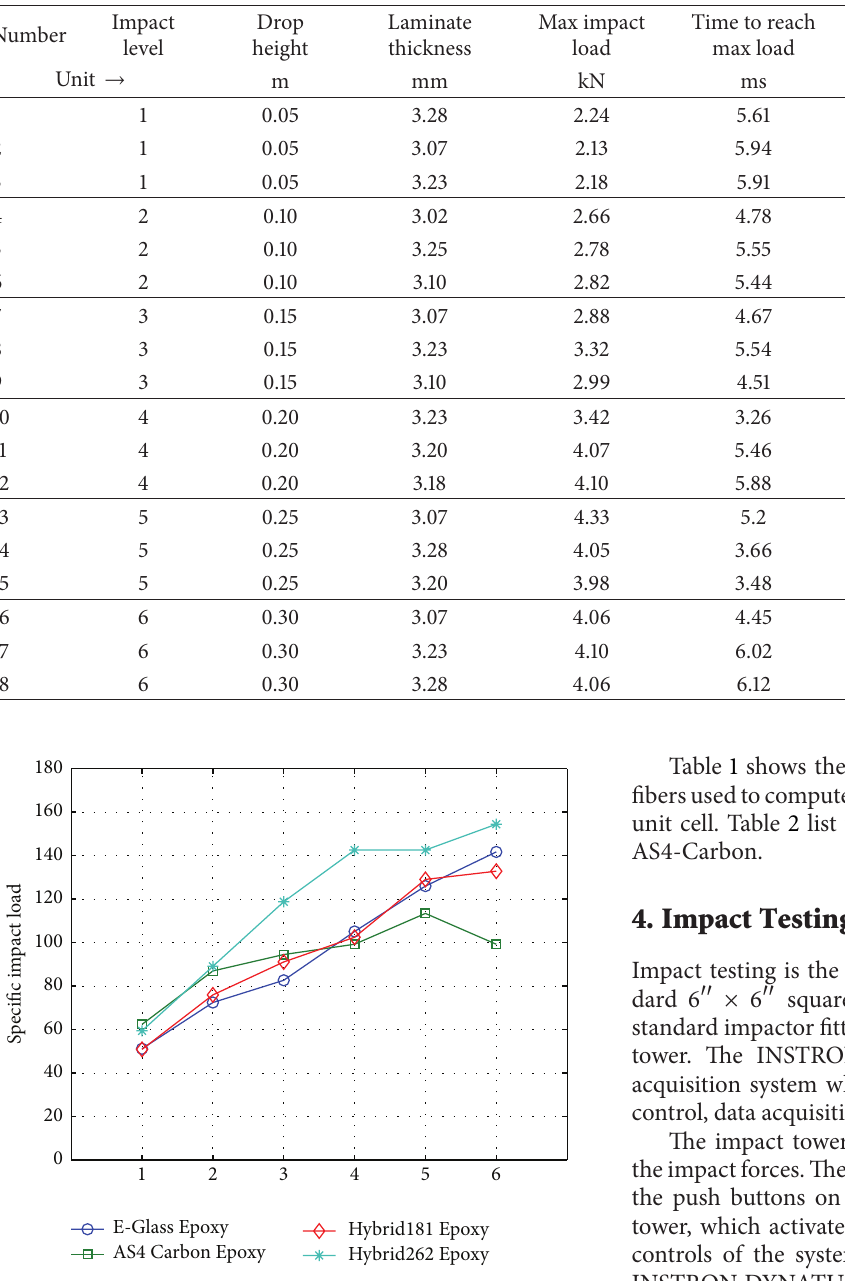
Figure 12: Specific impact load (ratio of load (N) to areal density (kg/m 3 )) versus loading level of progressive